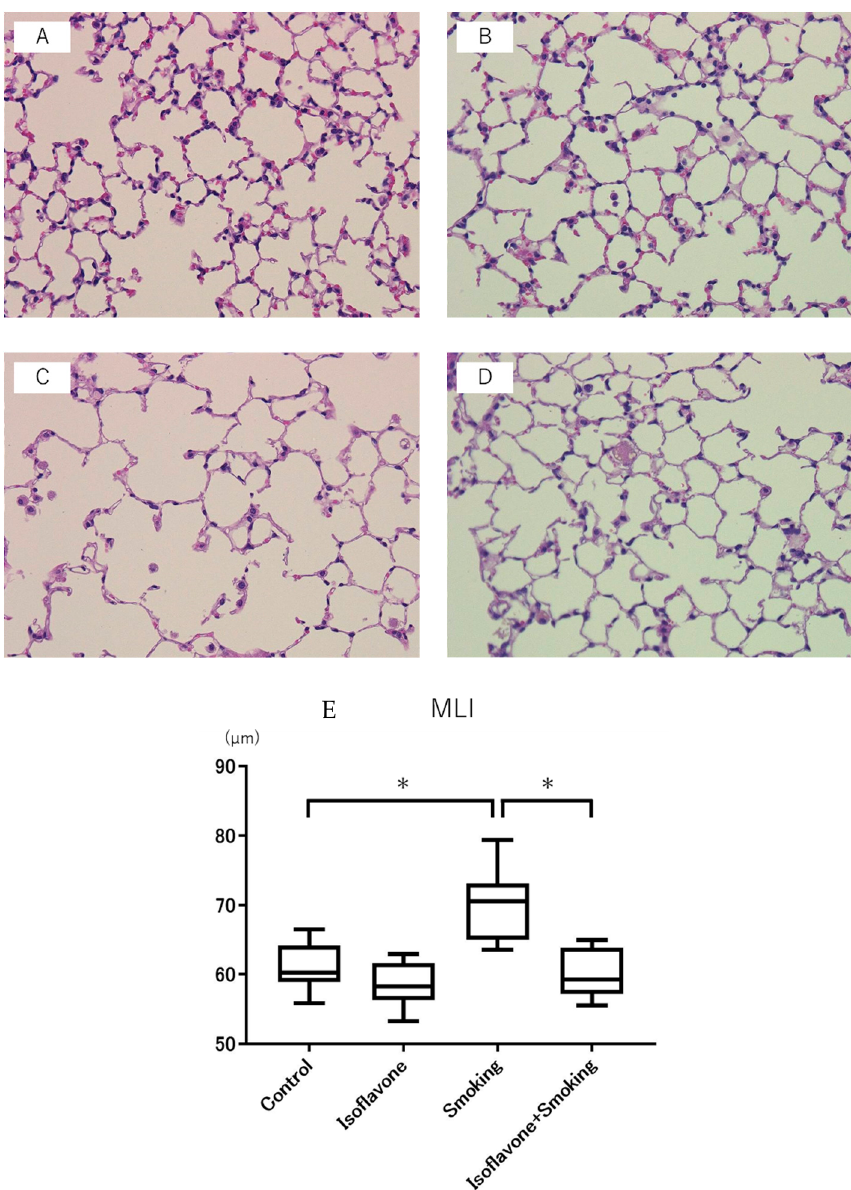
Figure 3. Representative micrographs of mice lungs stained with hematoxylin and eosin. Images of ( A ) control group, ( B ) isoflavone group, ( C ) smoking group, and ( D ) isoflavone + smoking group are shown at 200 × magnification. ( E ) Mean linear intercepts (MLI) in each group. Isoflavone significantly decreased the MLI. Data are shown with box and whisker plots. * p < 0.05.